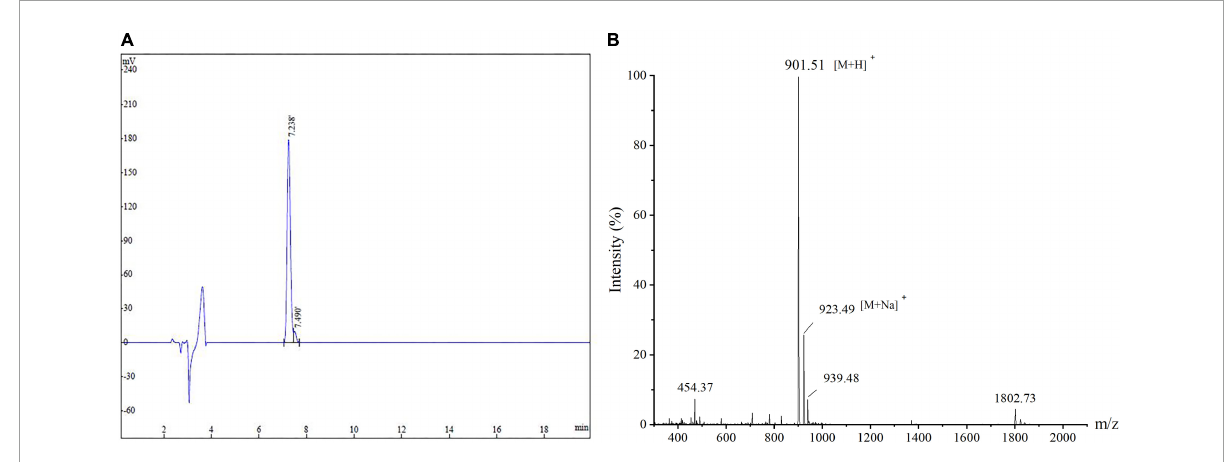
FIGURE1 The amino acid sequence and molecular mass identification of peptide AEYLCEAC by (A) HPLC and (B)